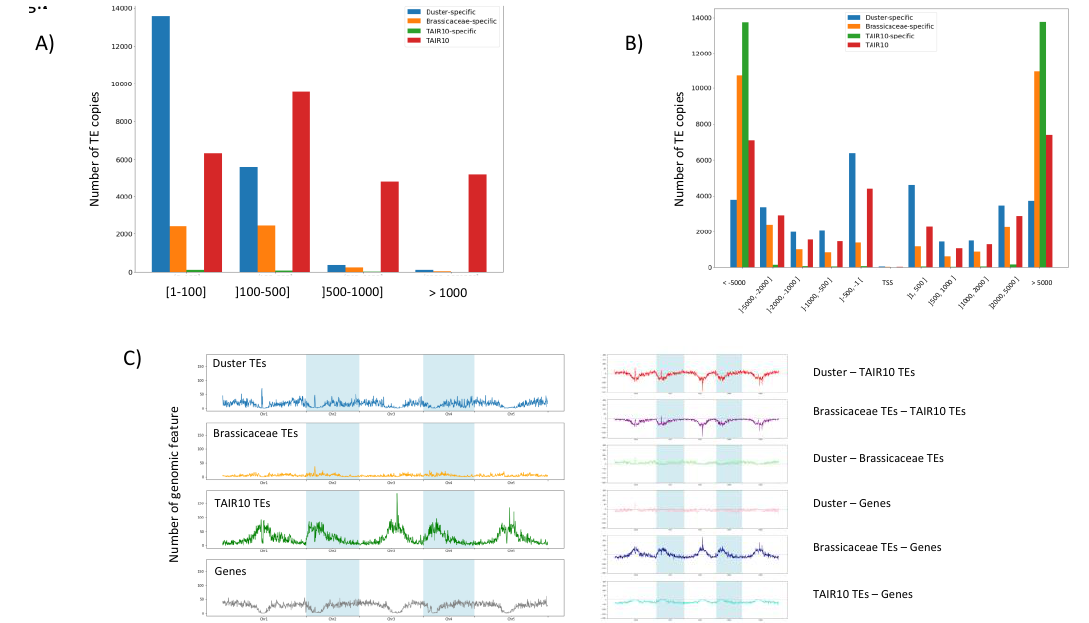
Figure 2 : Structural characteristics of Duster-specific, Brassicaceae-specific, TAIR10-specific, and TAIR10TE copies. (A) TE length distribution, (B) distance to the closest 5’, or 3’ TE copy for each annotated gene, (C) TE copy distribution on the chromosomes. Left panel: density plot, for 100 kb windows overlapping by 10 kb. Right panel: density differences, in 100 kb bins.